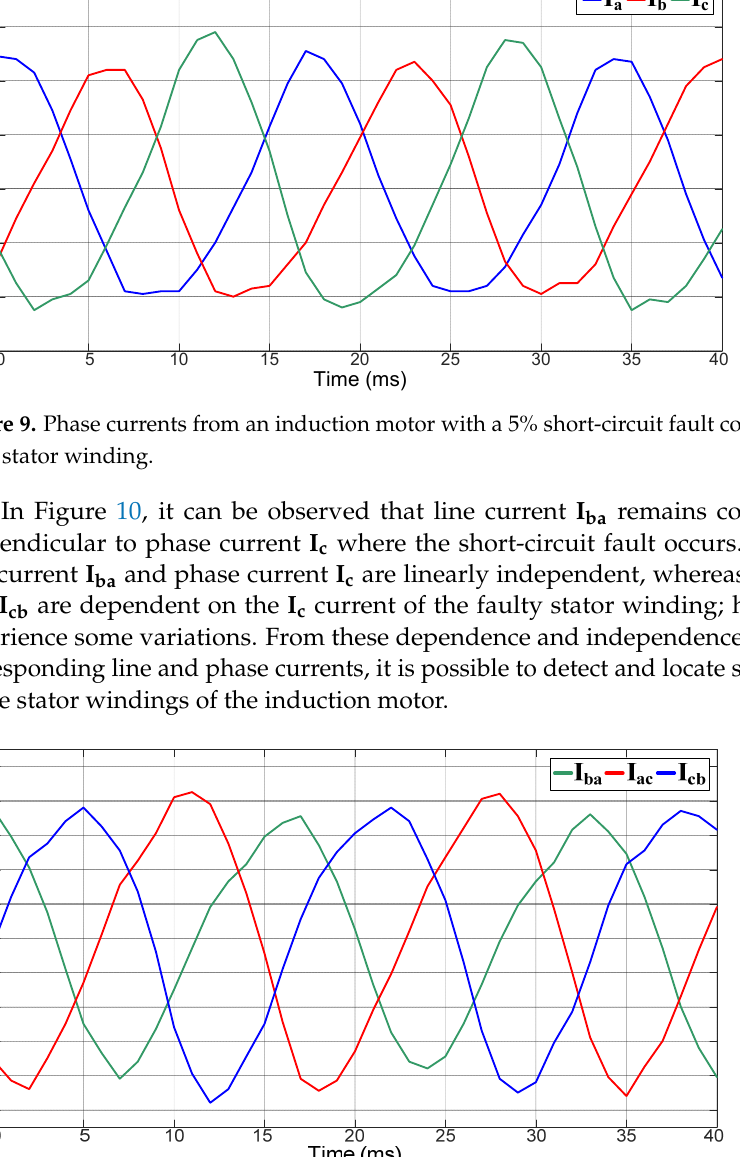
9 of 15 Figure 8. Line currents from an induction motor in healthy condition. The unbalanced phase and line currents from an induction motor with a 5% short- circuit fault in the phase-C stator winding using the tap T 2 of the start connection is